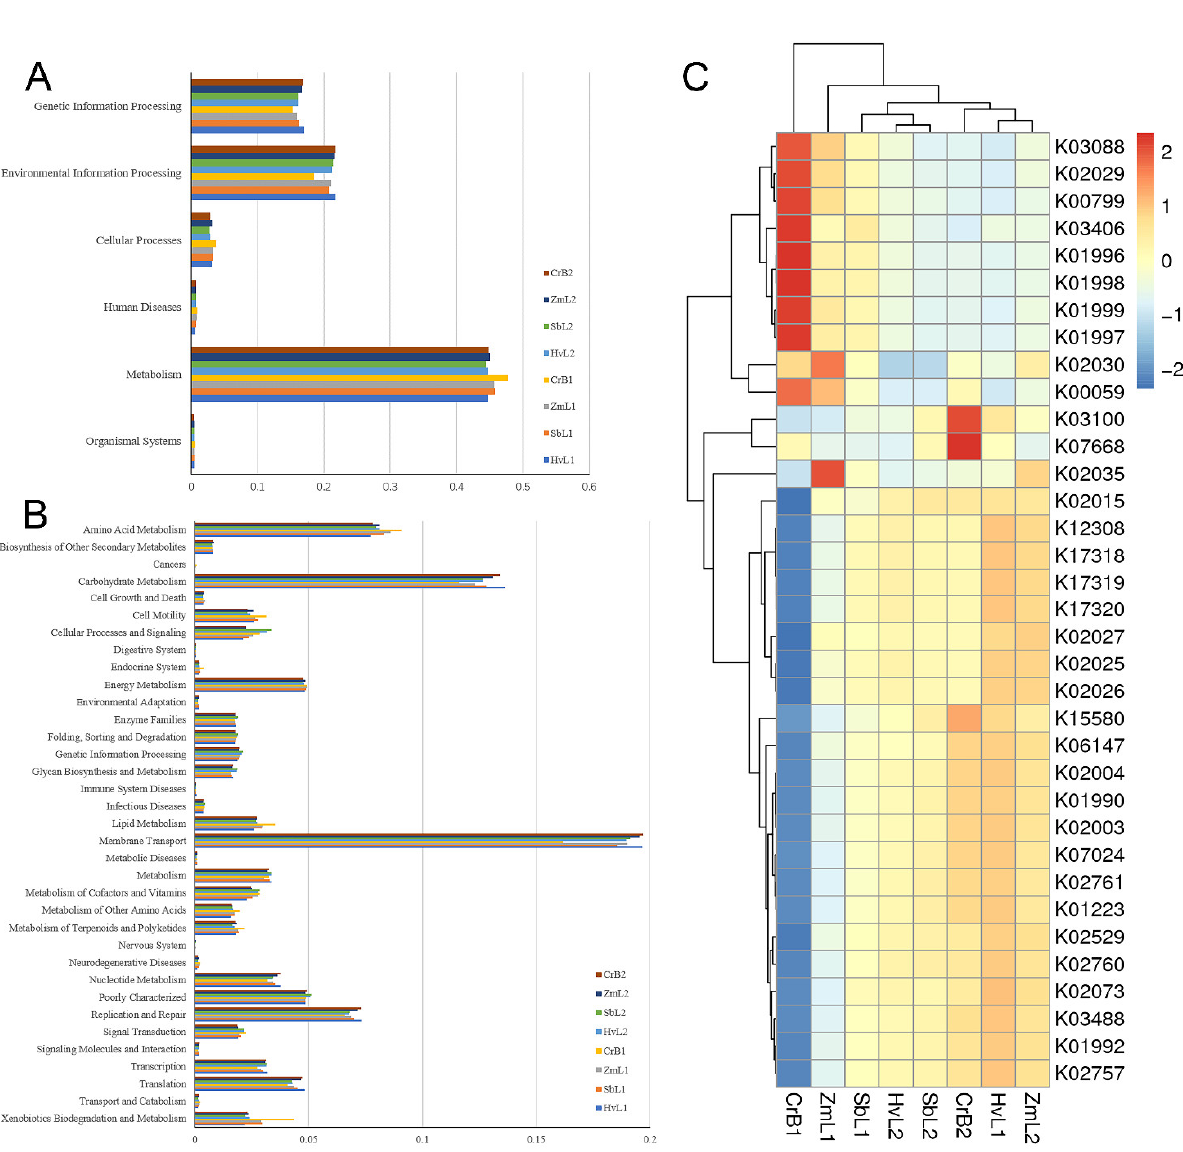
Figure 7. Annotations of KEGG-predicted functions of gut bacterial communities in S. frugiperda larvae fed on leaves of different host plants. ( A ) Level 1 and ( B ) level 2. ( C ) PICRUSt2 prediction of proteins based on functions in the KEGG database.